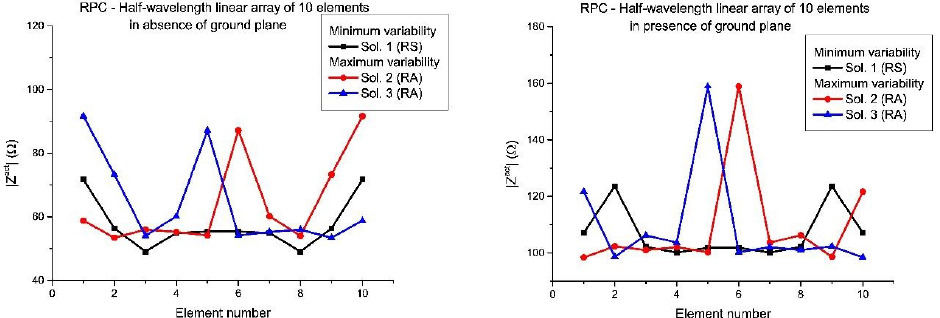
Figure 8. Detailed view of the active impedances which present the maximum and the minimum variability from the set of solutions for the RPC, in the case of the half-wavelength elements linear array of 10 elements: in absence of ground plane ( left ) and in presence of ground plane ( right ).